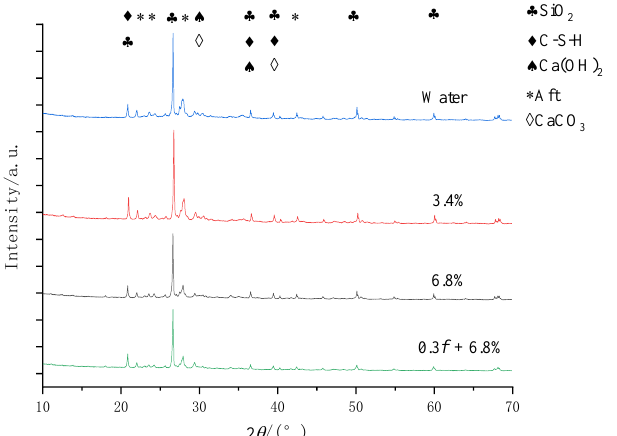
Figure 10. X-ray diffraction spectra analysis of concrete surface erosion after 100 freeze – thaw